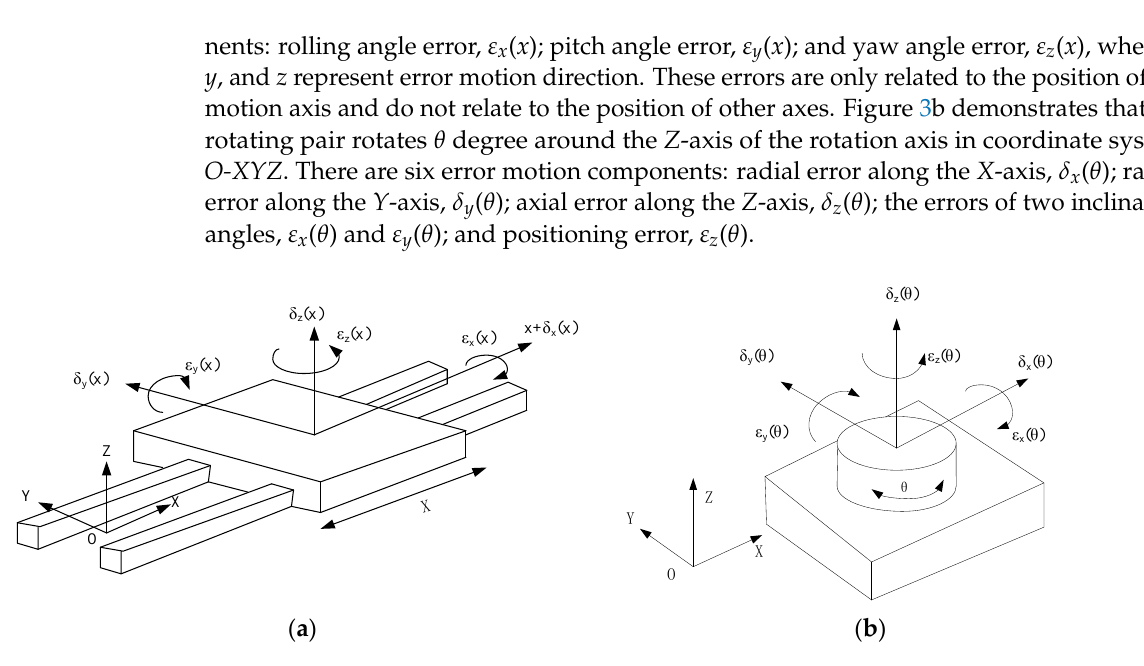
Figure 3. Geometric error element in relation to the position. ( a ) Geometric error element of move- ment pair. ( b ) Geometric error element of rotation pair. pair. ( b ) Geometric error element of rotation